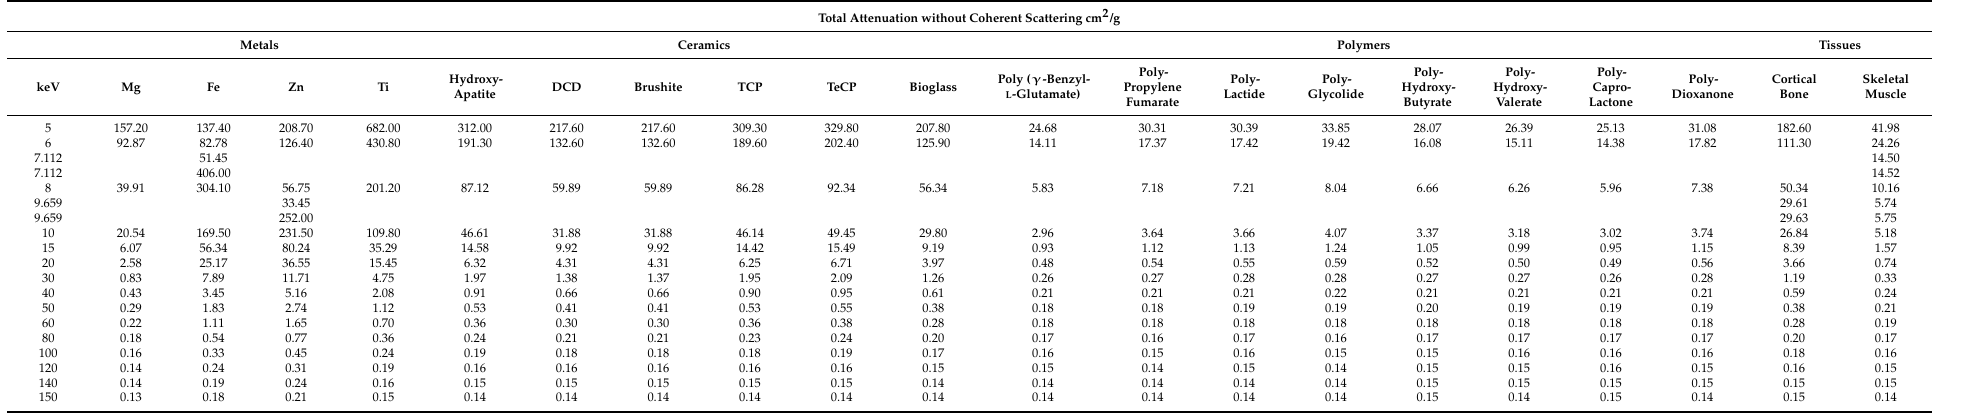
Table A1. Calculated total attenuation coefficients without coherent scattering for biodegradable implant materials, titanium, cortical bone and skeletal muscle from to 5 to 150 keV.